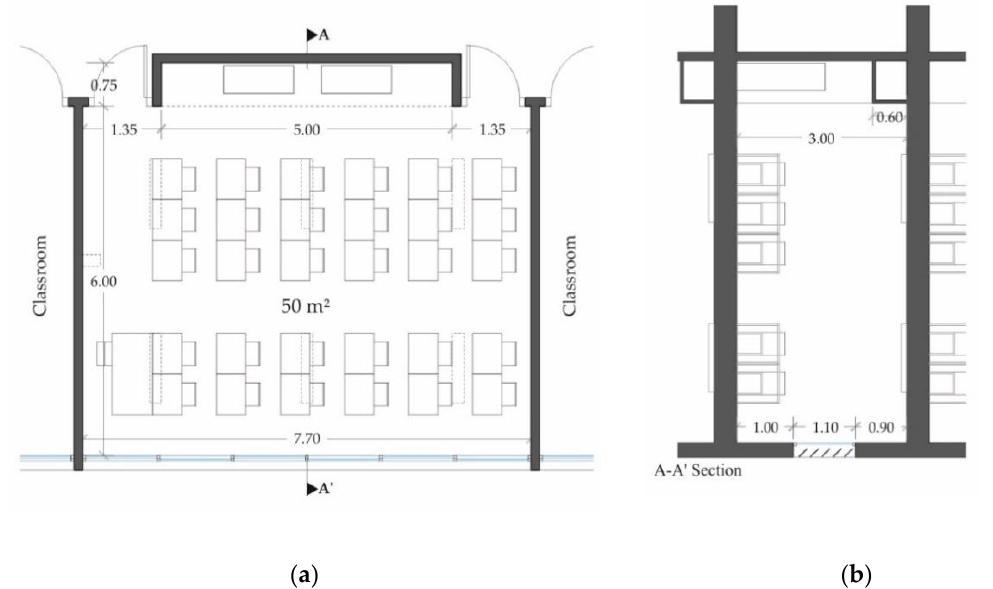
Figure 1. Multipurpose classroom according to Andalusian design standards: ( a ) Plant with windows, doors, and furniture standard distribution. ( b ) A-A’ vertical section.